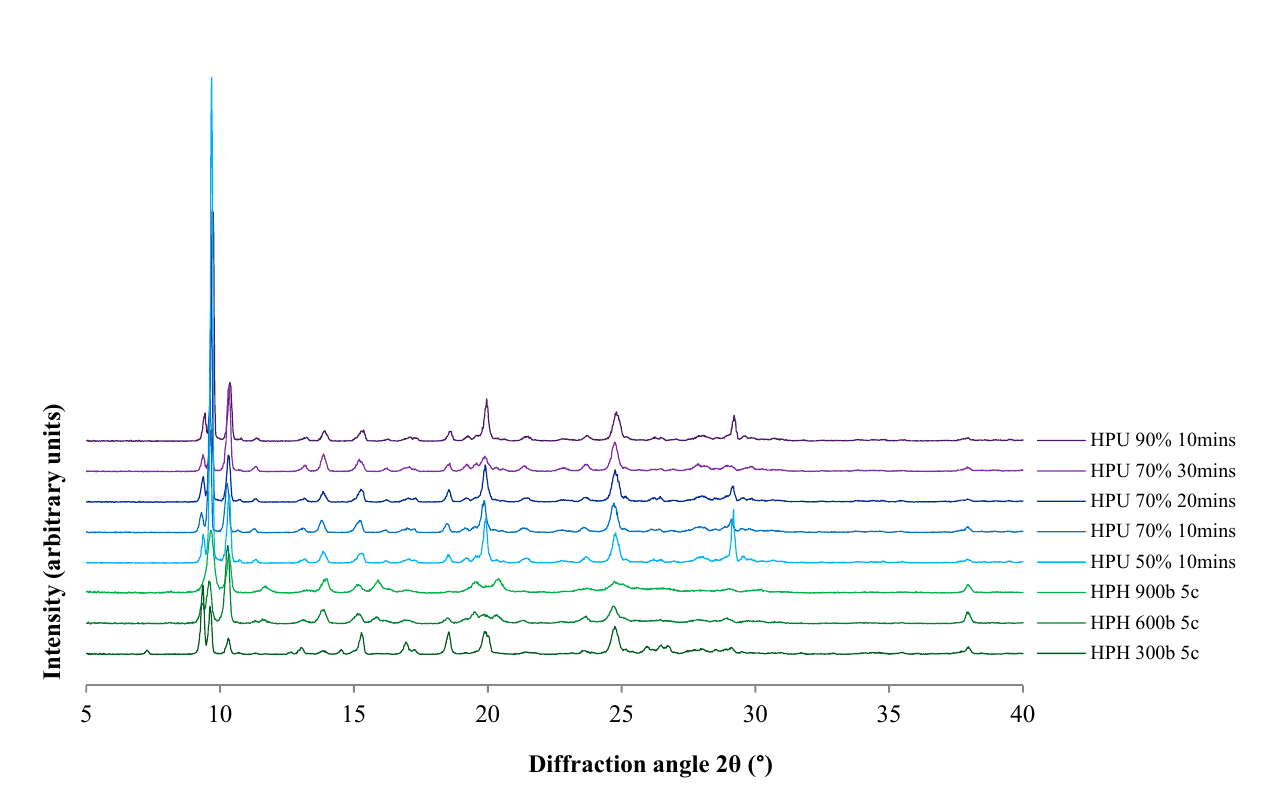
Figure 3. Powder X-ray diffraction (PXRD) patterns of the cocrystals prepared by HPH and high-power ultrasound. HPH: high pressure-homogenization; HPU: high-power ultrasound; c: number of HPH cycles; percentage refers to HPU amplitude.